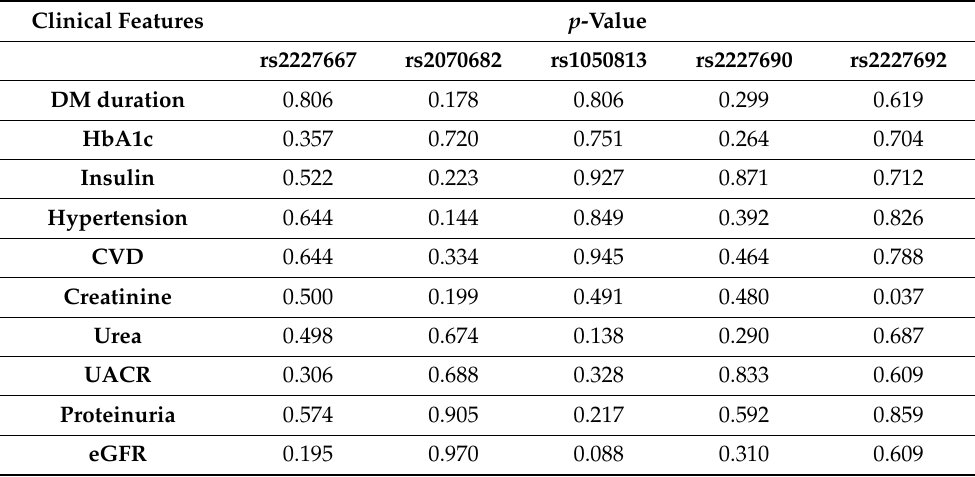
Table 3. Correlation of clinical features with individual